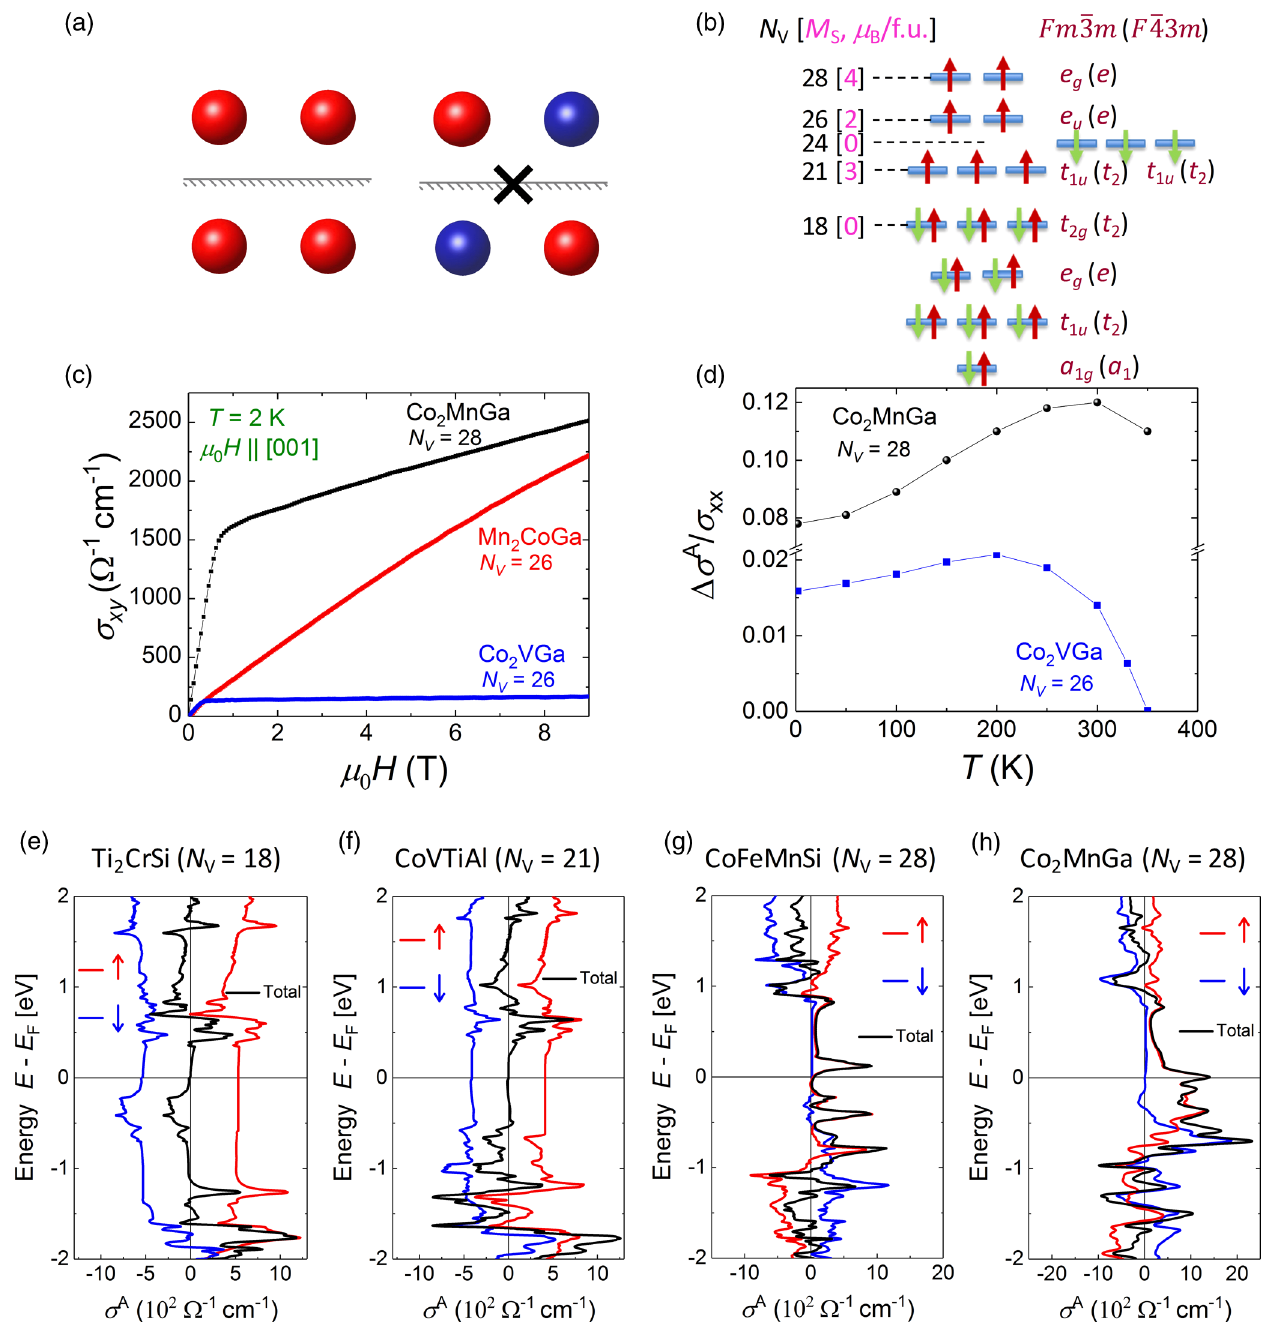
FIG. 5. (a) Breaking of mirror symmetry by chemical substitution in the compound. (b) Schematic representation of the distribution of valence electrons in various electronic energy levels for both spin channels and the corresponding net magnetic moment. (c) Experimentally observed Hall conductivity of three magnetic Heusler compounds with various N V . (d) Temperature dependence of the anomalous Hall angle for two regular Heusler compounds, Co 2 MnGa and Co 2 VGa. Hall contributions of the majority and minority spin channels and the net anomalous Hall conductivity for (e) Ti 2 CrSi, (f) CoVTiAl, (g) CoFeMnSi, and (h) Co 2